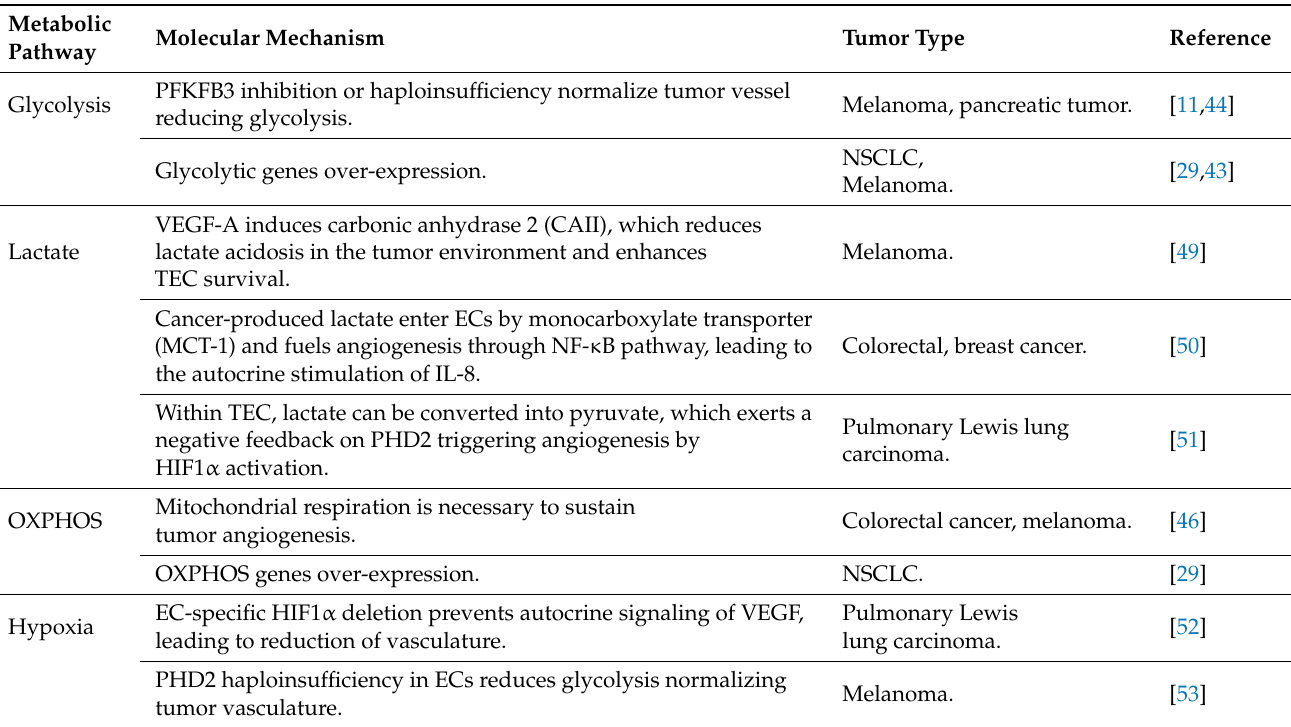
Table 1. Direct in vivo evidence of TEC metabolic reprogramming that impairs tumor vasculature and consequently cancer